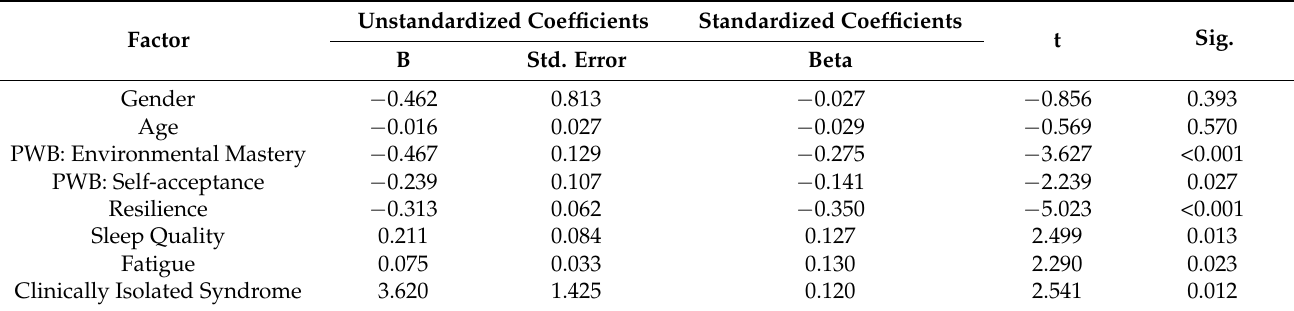
Table 5. Perceived Stress: a multivariable linear